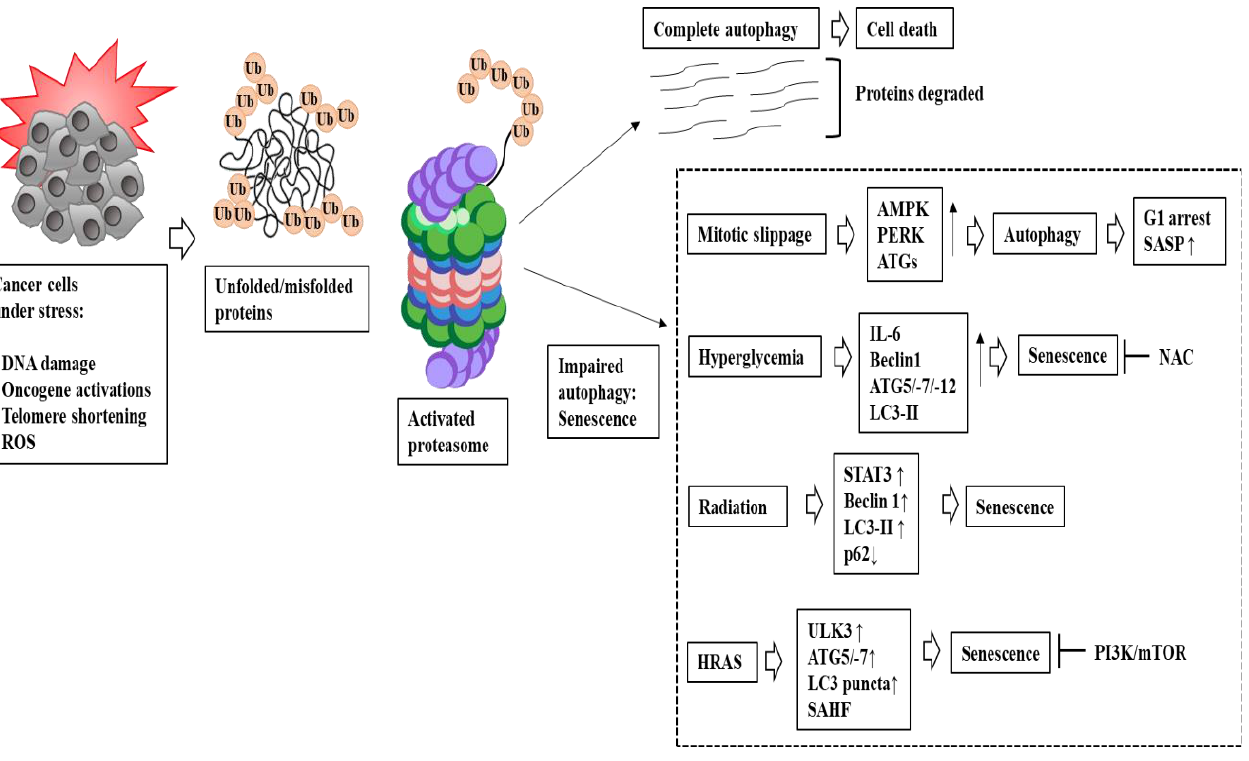
Figure 5. Autophagy leads to the induction of senescence. Autophagy is induced in cancer cells under various stresses. Complete autophagy usually results in cell death. Incomplete autophagy leads to senescence. ↑ indicates an increase in expression/activity. ↓ indicates a decrease in expression/activity. Hollow arrows and black arrows denote the direction of the reaction. The T bar indicates negative regulation. ULK3 is unc51-like autophagy activating kinase 3 and Ub is ubiquitin.